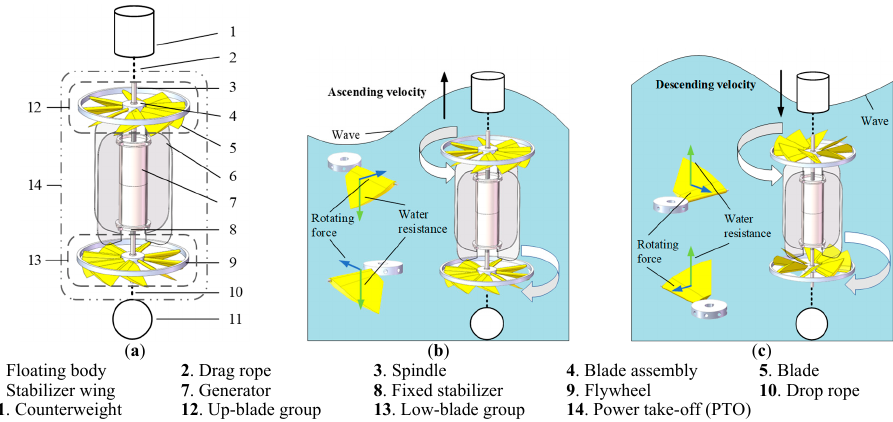
Figure 3. ( a ) Point ‐ absorption WEC structure; ( b ) ascending process; ( c ) descending process. As shown in Figure 3b, when the floating body 1 ascends with the wave, the PTO 14 ascends together under the traction of the drag rope 2, and the blade groups 12 and 13 of the PTO are deflected downward due to water resistance during the ascending process.